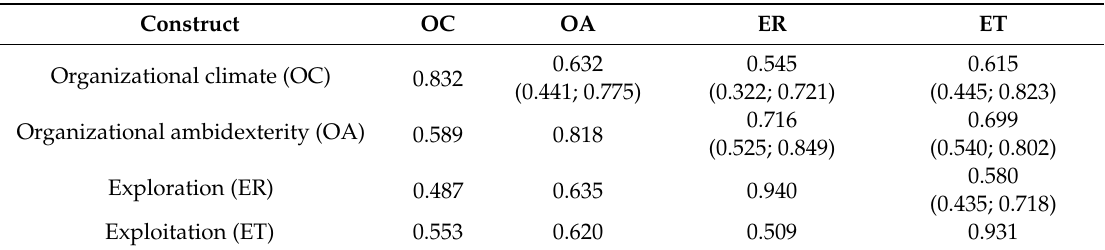
Table 2. Assessment of discriminant validity using the Fornell and Larcker criterion and the Heterotrait-Monotrait Ratio (HTMT).